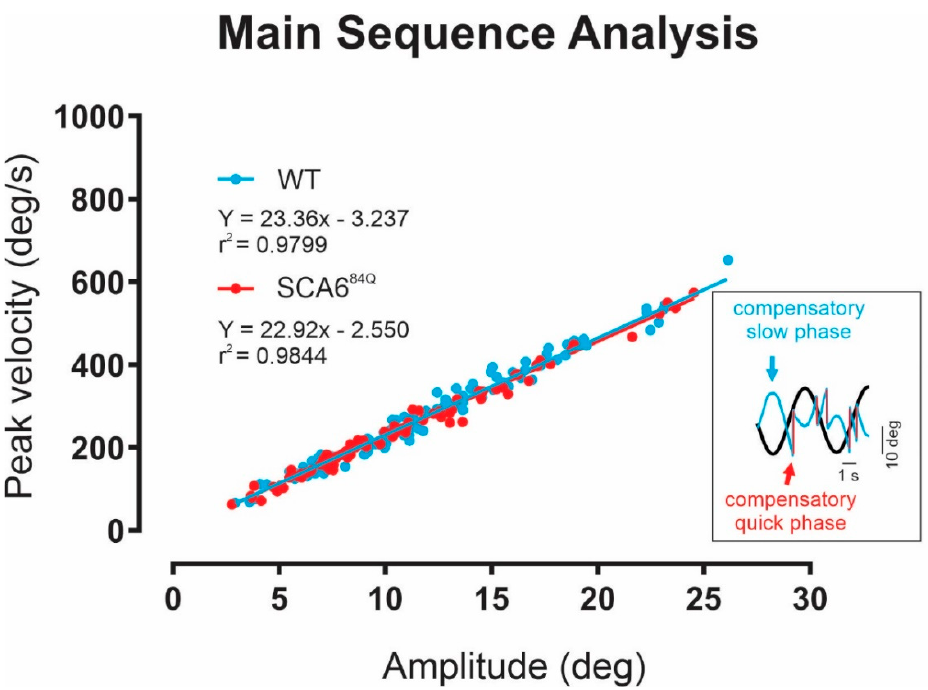
Figure 2. Nystagmus dynamics are comparable between wild-type and SCA6 84Q mice. Peak velocity vs. amplitude relationship for fast phases of vestibular nystagmus for wild-type (WT, blue dots) and SCA6 84Q mice (red dots). Regression lines are superimposed. There is no significant difference between the two slopes ( p = 0.2797).